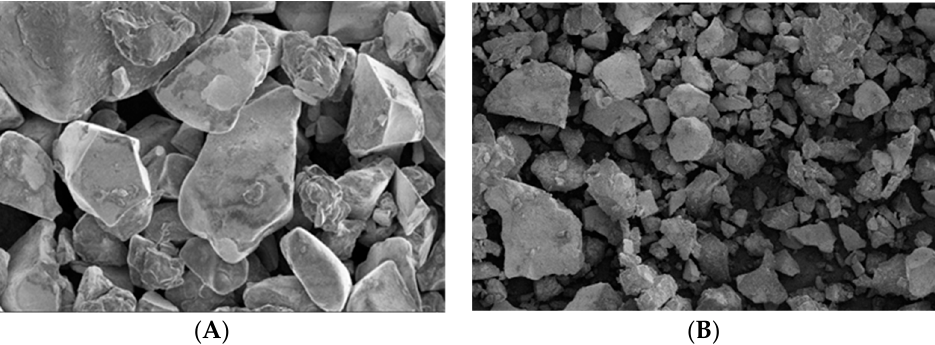
Figure 1. ( A ) Surface morphology structure of the β -CD-EPI polymer-modified Fe 3 O 4 nanoparticles (2.0 kV; magnification 100×). ( B ) Surface morphology and structure of the powder of the β -CD-EPI polymer-modified Fe 3 O 4 nanoparticles (2.0 kV; magnification 150×).